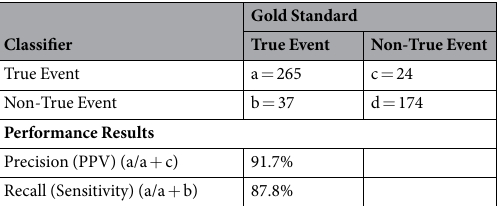
Table 1. Classifier Performance Results for Suicide Ideation (n = 500